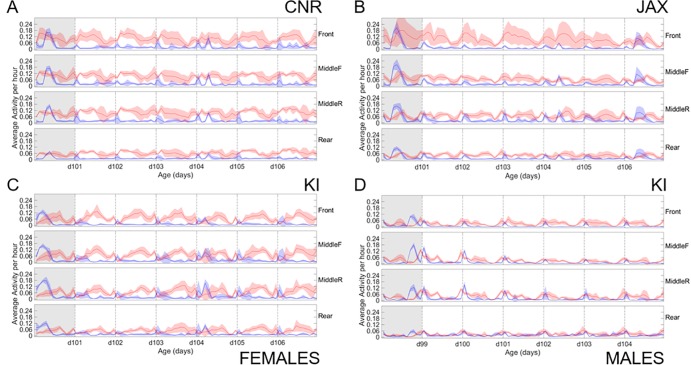
Distribution of activity during day and night time across the cage floor area at CNR, JAX and KI.Actigrams showing average activity in cages (A-D) during lights-on and lights-off in the front, middle-front, middle-rear and rear rows of electrodes at the three sites. Continuous activity (ordinate) data during one weeks (abscissa; age of the animals in days) from the cages with female mice at CNR (A), JAX (B), and KI (C) followed by the cages with male mice at KI (D). In A-D grey shaded area indicate day of cage-change. As in Fig 2 the blue trace (plotted as average per h based on activations per minute) is the average daytime activity (each bin starts at lights-on, and ends at lights-off) and shaded blue area denotes the standard deviation. The superimposed red trace is average activity during lights-off (each bin starts at lights-off and ends at lights-off; 12 hrs. phase shift from the daytime data) with the standard deviation indicated as red shaded area around the average trace. Note the overall lower level of activity recorded from rear area of the cage floor across sites and sexes. The level of activity day and night time is clearly lower in cages with male mice compared with cages holding female mice at KI. For further information, see text.